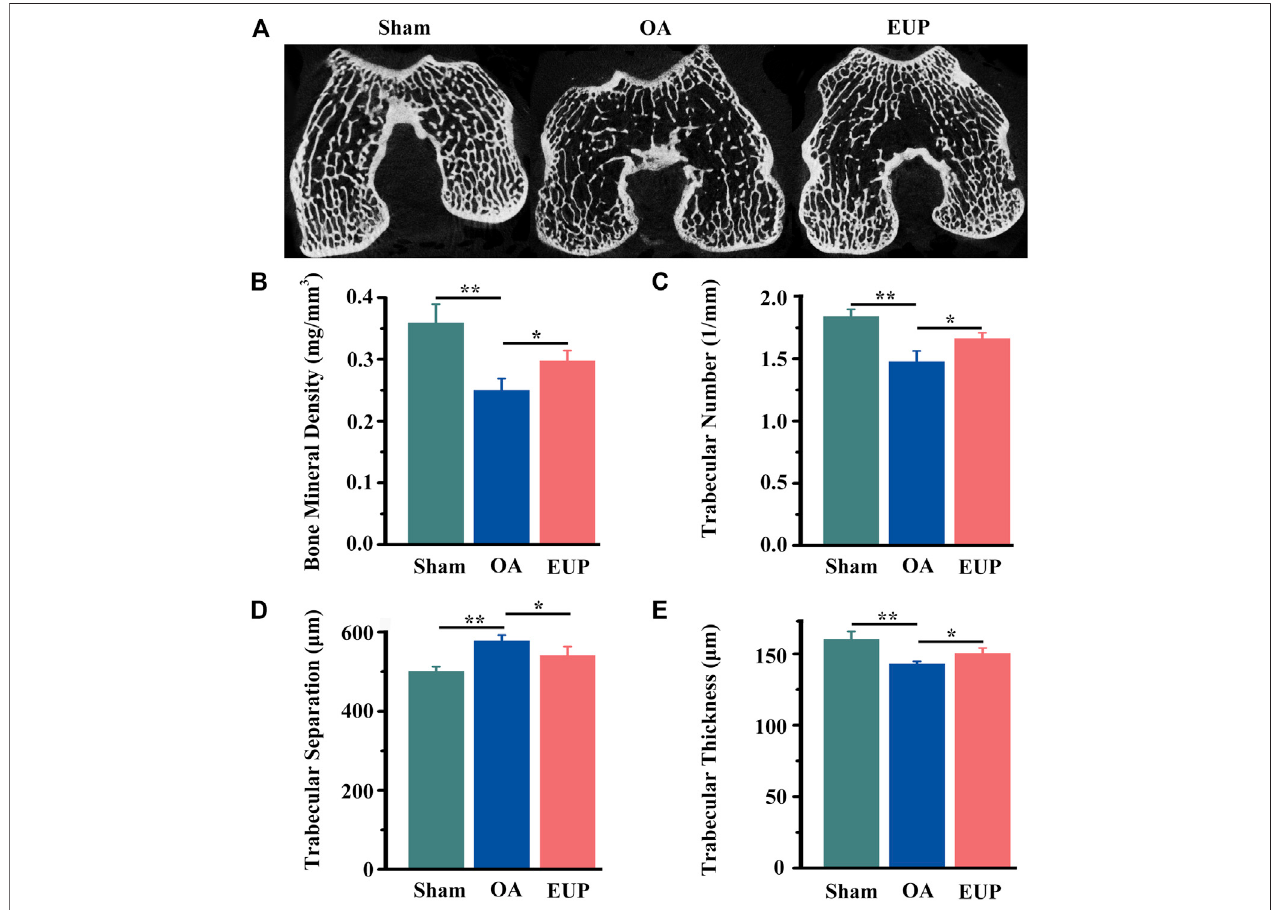
FIGURE3| EUPwasbene fi cialtothereconstructionofsubchondralboneinearlyosteoarthritis. (A) Micro-CTscanofthesubchondralboneofthefemoralcondyle. (B) The BMD of trabecular bone of subchondral bone. (C) The number of trabecular bone. (D) The separation of trabecular bone. (E) The thickness of trabecular bone. *, ** indicate statistically signi fi cant differences ( p < 0.05 and p < 0.01,